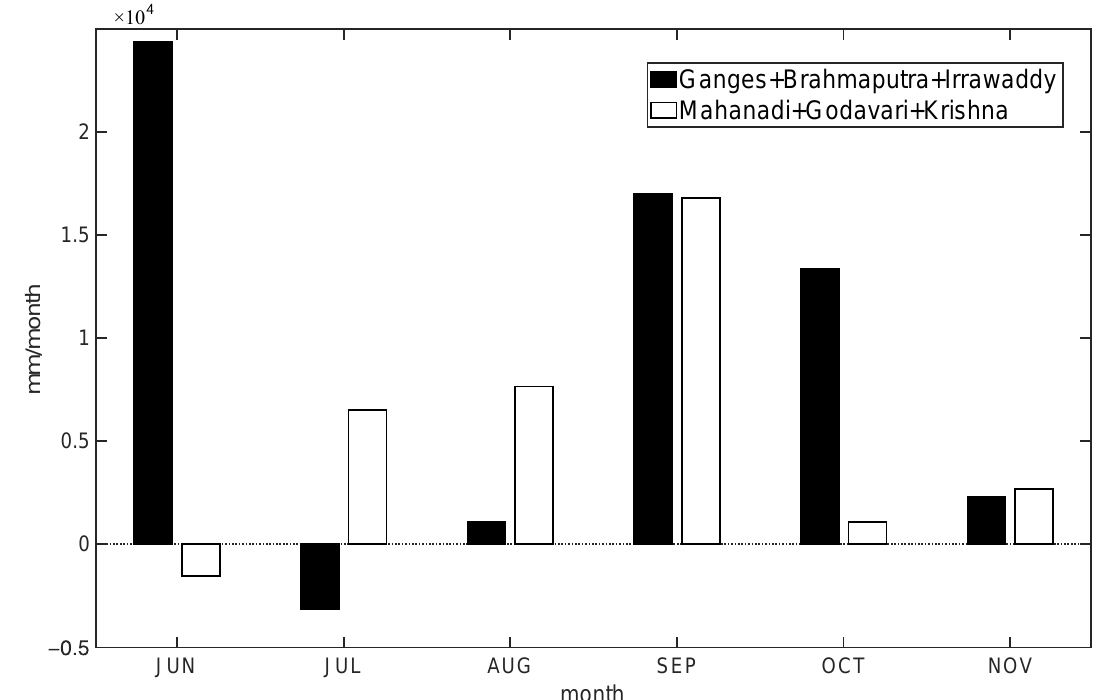
Figure 11. The anomalous runoff along the west (white bars) and north (dark bars) coast of the BoB from June to November 2010.